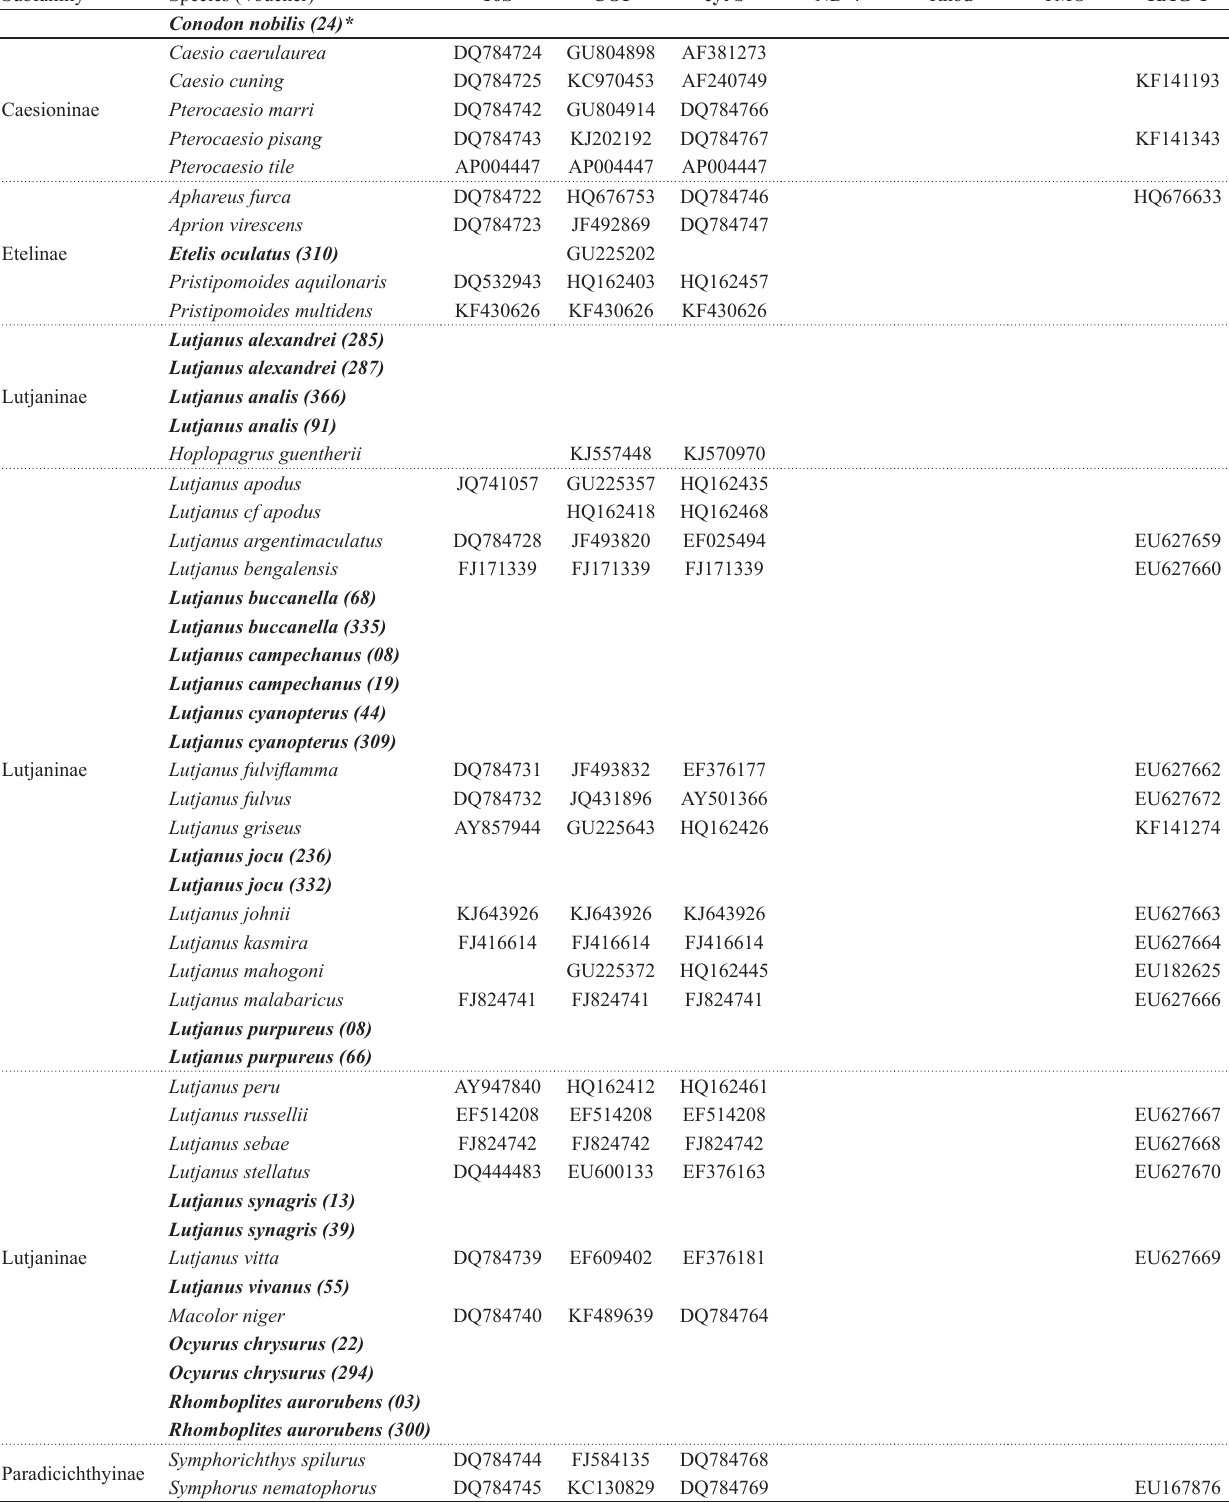
Tab. 1. Markers and their evolutionary rates included in the present study, with respective Genbank access codes of sequence data. The species in bold represent specimens samples in the present study selected for the phylogenetic analyses (BI and ML) in Western Atlantic species of Lutjaninae, based on all markers. The total set of species was used to infer the evolutionary relationships and the origin of Lutjanus alexandrei within Lutjanidae, based on the highlighted markers. * Haemulidae representatives used as outgroups used in phylogenetic